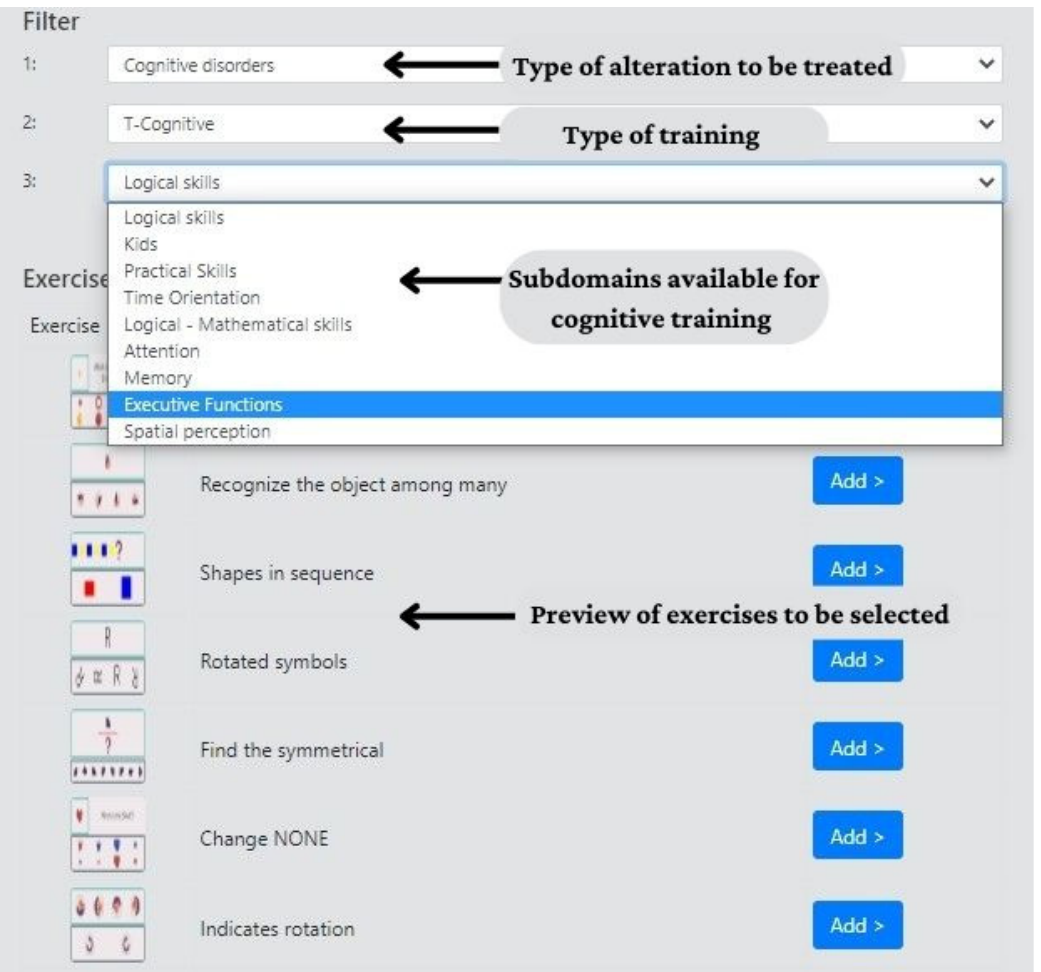
Figure 2. VRRS main screen showing the subdivision of the cognitive exercises into the various sub- domains and categories. subdomains and